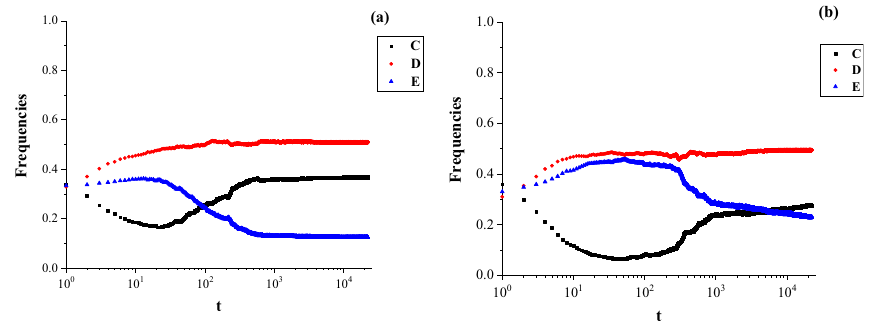
Figure 4. The extortion game in hypernetworks. We assume that the parameters m 1 = 2, b = 2 , and c = 1 . Stability of cooperation (C), defection (D), and extortion ( E χ ) strategies: ( a ) relatively fair extortioner ( χ = 2 ); ( b ) relatively unfair extortioner ( χ = 4